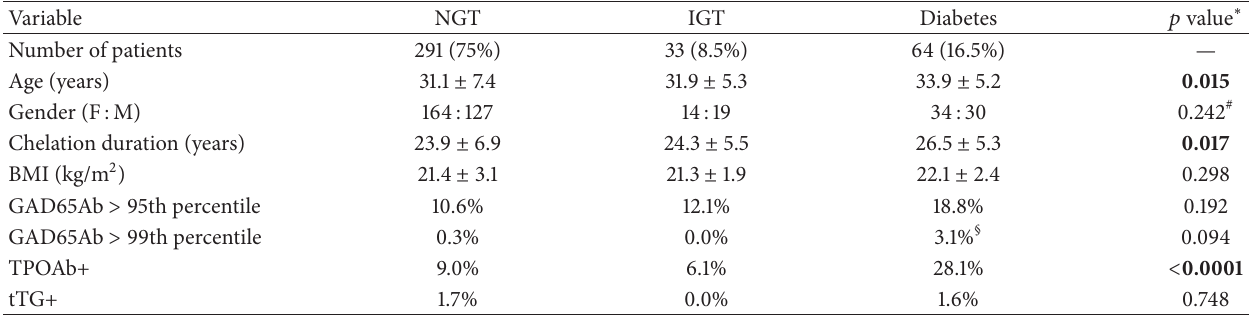
Table 1: Characteristics of 388 thalassemic patients according to the presence of disorders of glucose metabolism. Variable NGT